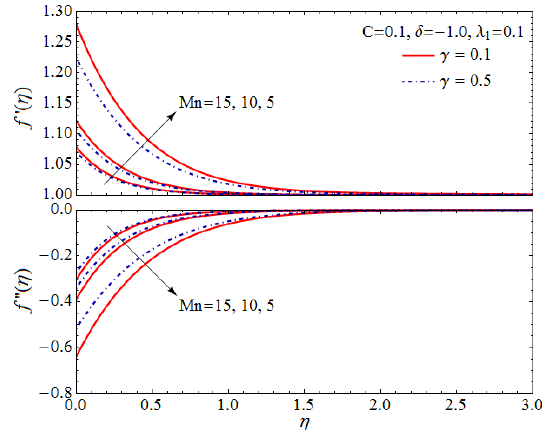
Fig. 5 Dimensionless velocity profile f (cid:48) ( η ) and shear stress profile f (cid:48)(cid:48) ( η ) for various values of Mn and λ 1 .